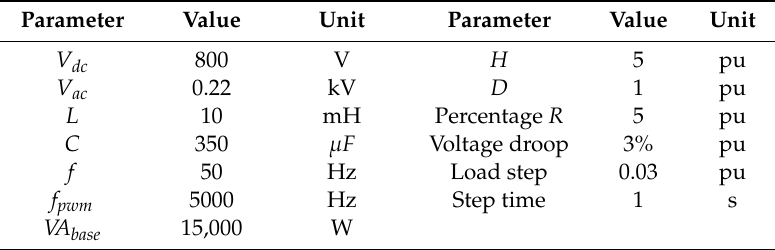
Table 5. Parameters in simulation.